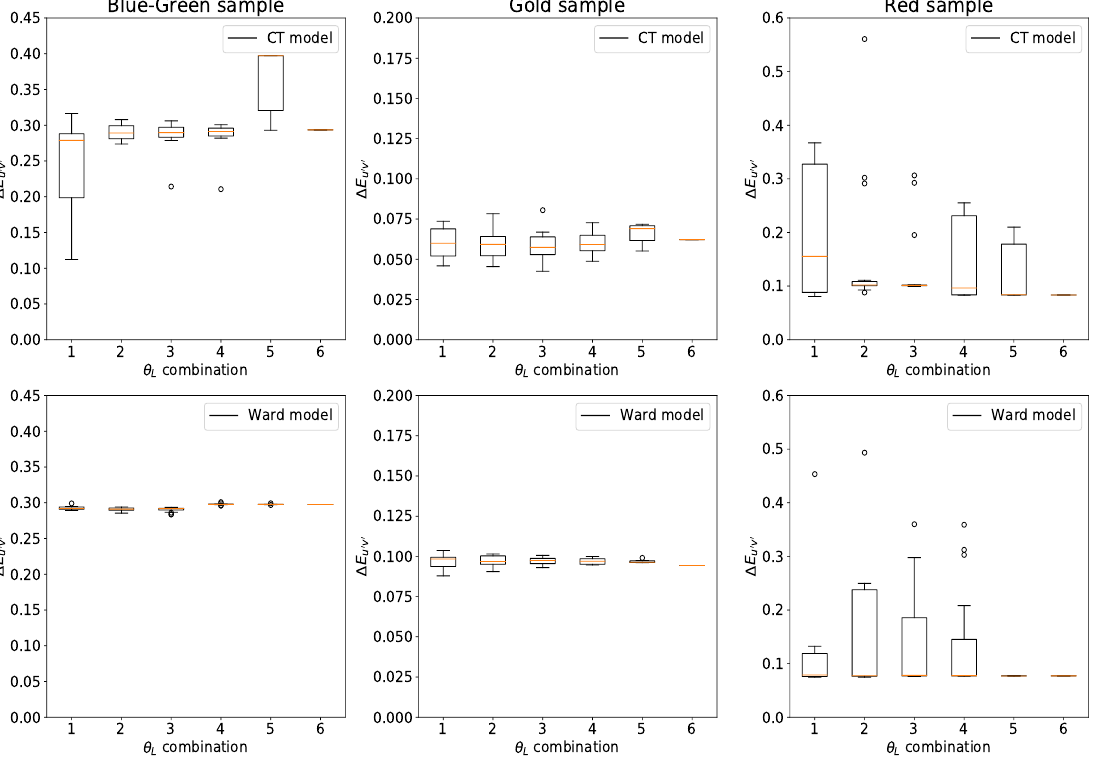
Figure 9. Box-and-whisker plots showing average ∆ E between camera RGB data calculated from u (cid:48) v (cid:48) GCMS measurements and data estimated using both models of all the samples. The orange line in the boxes shows the median error value obtained between the θ L combinations used for model fitting. Circle dots are large ∆ E error obtained (approximately three-times the range of error variation u (cid:48) v (cid:48) (boxes)